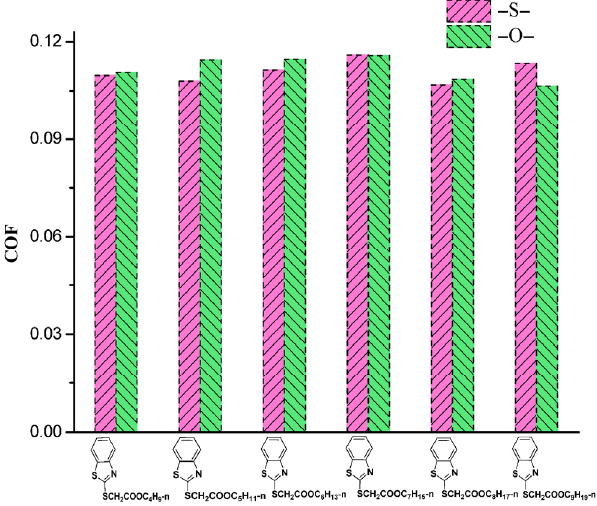
Fig. 25 The friction coefficient when lubricating with 2- benzothiazole-S-carboxylic acid esters and their isosteres in TMPTO.